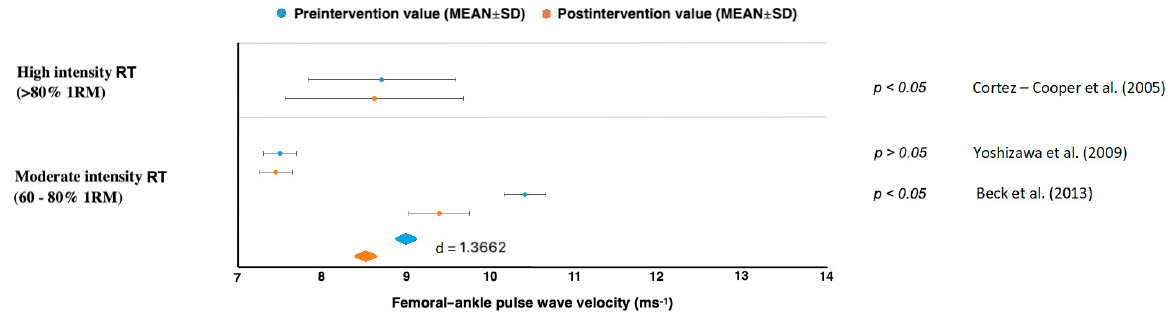
Figure 4. Femoral–ankle pulse wave velocity changes. RM = repetition maximum, SD = standard deviation.